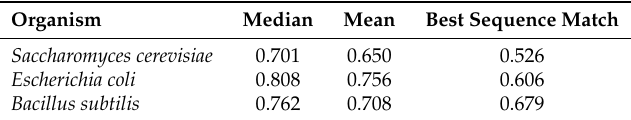
Table 2. Pearson correlation coefficients between the logarithms of k cat values from the organism of interest and the logarithms of the mean, median and best sequence match k cat values obtained from other